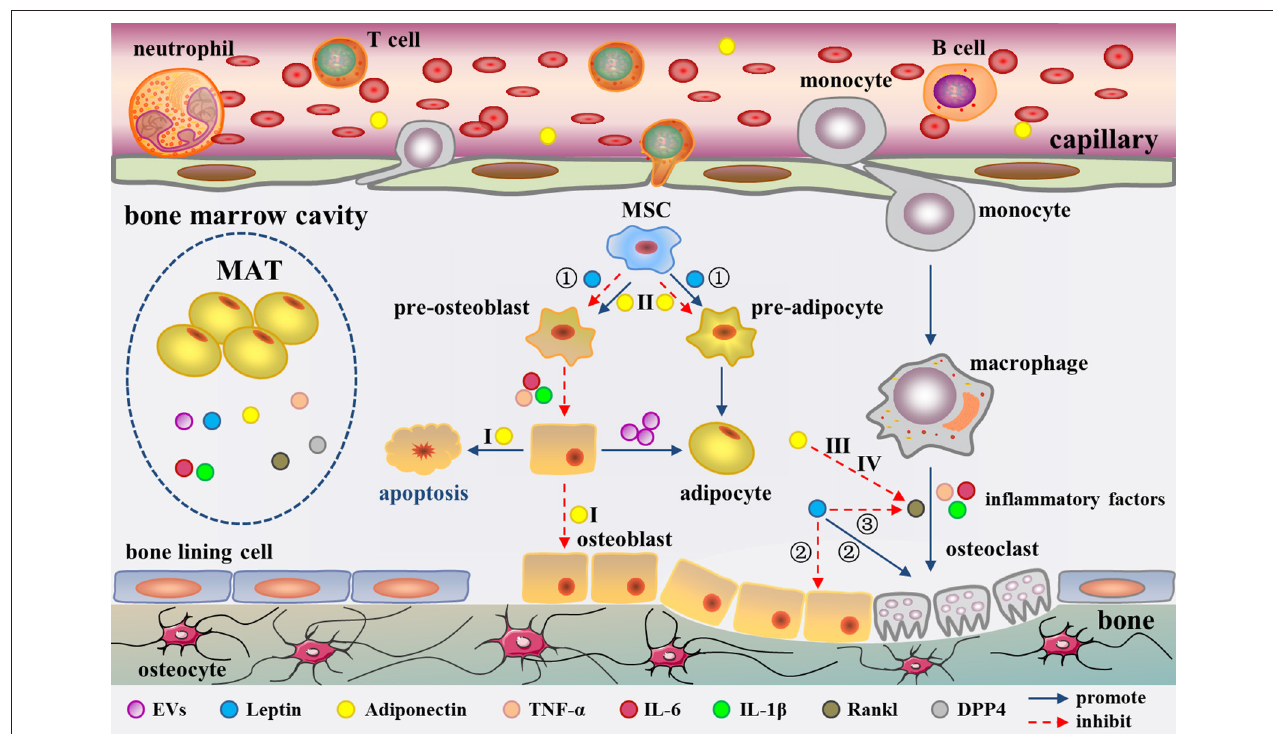
FIGURE 2 | Secretion of MAT as well as adipocyte-derived molecules in the regulation of bone metabolism in the bone marrow cavity. MAT could secrete EVs, leptin, adiponectin, inflammatory factors, RANKL, and DPP4. These factors regulate bone metabolism from different aspects. Among them, adiponectin has been confirmed to enter into the circulation. EVs cause a phenotypic transformation of osteoblast to adipocyte. Leptin regulates bone metabolism in three ways ( À - Â ). Moreover, Adiponectin regulates bone metabolism through four pathways (I-IV). Inflammatory cytokines promote osteoclast formation and adipocyte differentiation. RANKL promote osteoclast formation. The role of DPP4 in bone marrow cavity remains